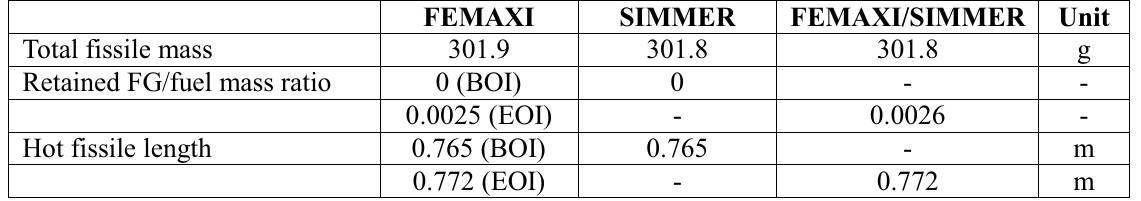
Table III. SIMOFE verification: FEMAXI-to-SIMMER data